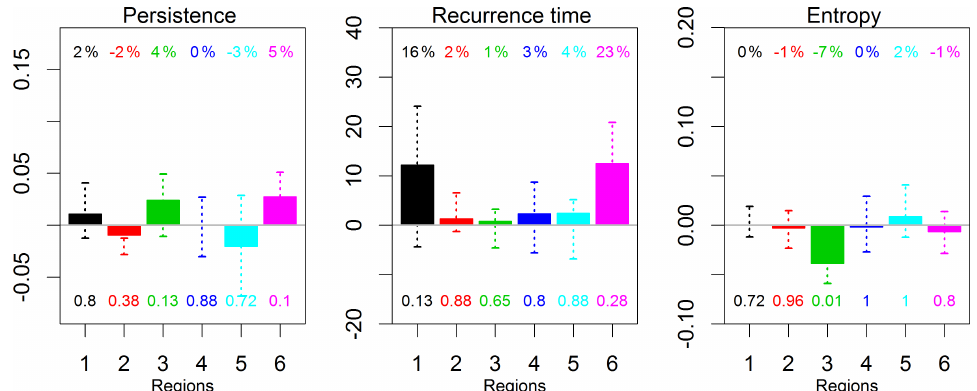
Figure 11. Climate change signal of descriptors for hot and dry extremes in summer (JJA) (Ta > 90th percentile and EDI < 25th percentile). Changes between the time periods 1971–2000 and 2021–2050. Bars show the ensemble mean (of the individual change signals) and whiskers the 75th and 25th quantile, respectively. Percentages above the bars denote the relative change of the ensemble mean, the numbers below the p value. The coloring corresponds to the regions in Fig.